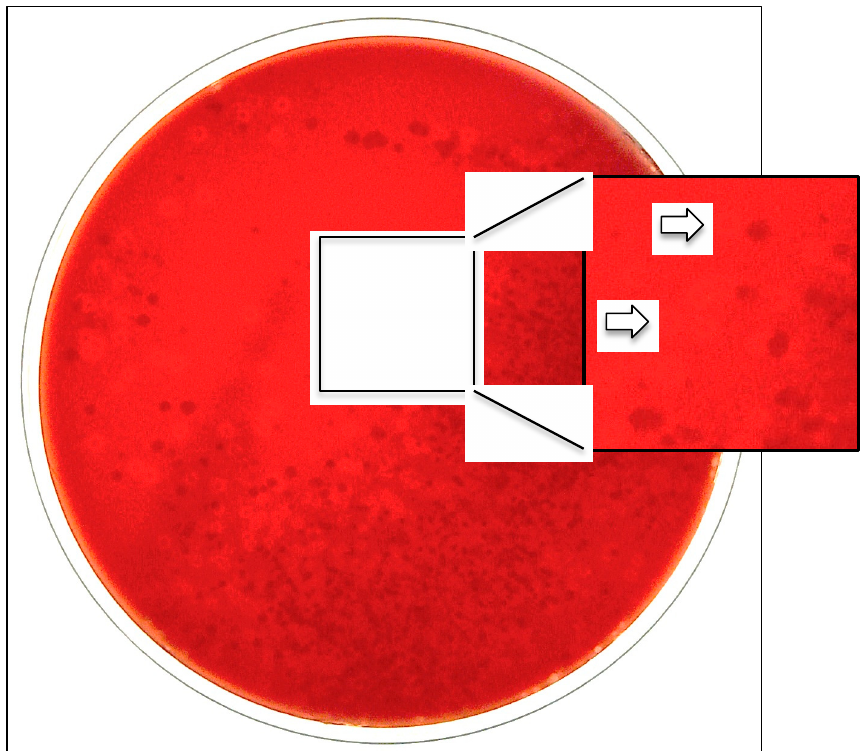
Figure 2. Oropharyngeal specimen seeded onto selective BAV medium exhibiting growth of β -he- molytic K. kingae colonies. β -hemolytic K. kingae